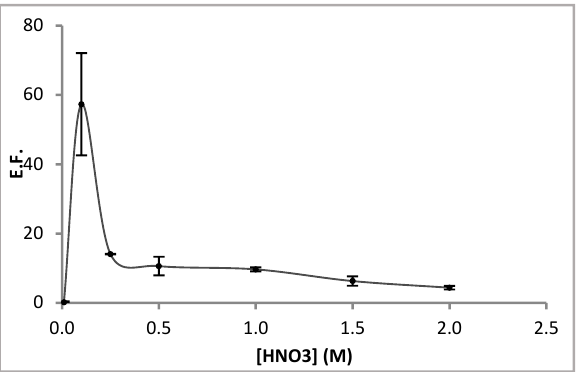
Figure 5. Effect of HNO 3 concentration on the enrichment factor. Sample: 0.1 µg L −1 Cd 2+ in NaNO 3 1 M and HEPES 0.1 M. Liquid membrane: Cyanex ® 272 1 M in dihexyl ether. Extraction time: 180 min. Fibre length: 6 cm. Stirring rate: 200 rpm.